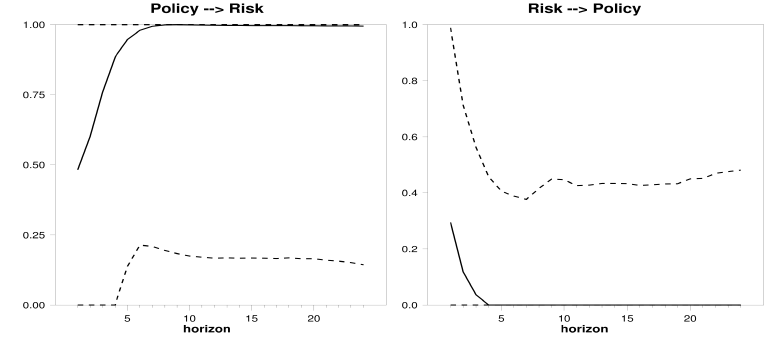
Figure 8. Dashed lines represent the 90% confidence intervals; the values of our measures are between 0 (not significant) and 1. z = ROE .